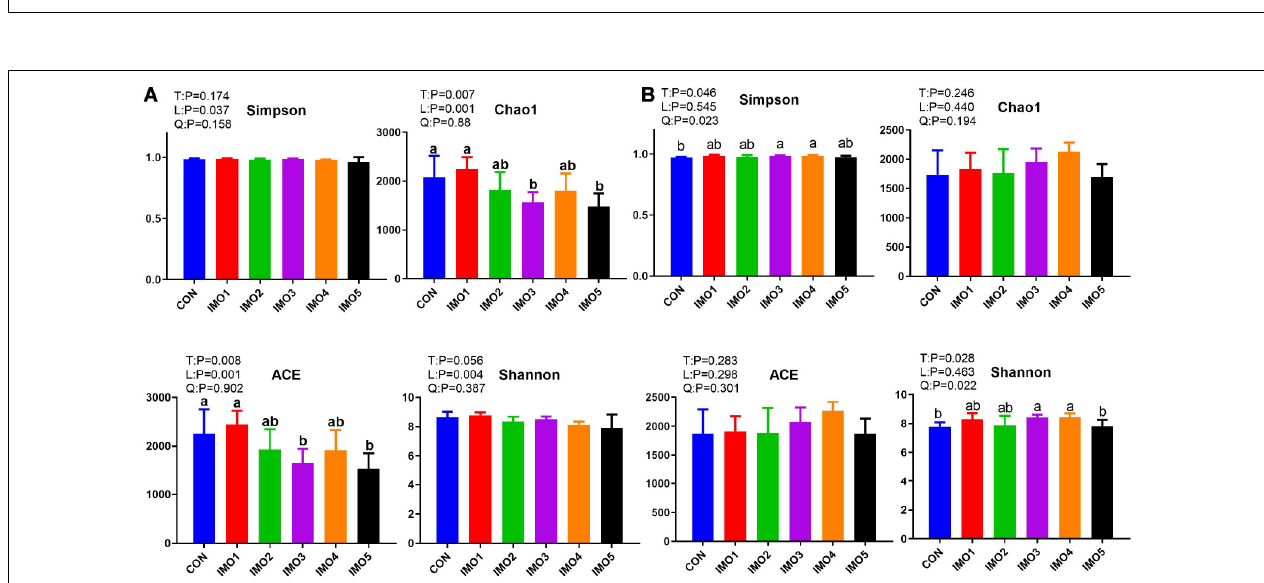
FIGURE 5 | Effects of dietary isomaltooligosaccharide (IMO) levels on the α -diversity of gut microbiota at day 107 of gestation (A) and at day 10 of lactation (B) of sows. Simpson index, Chao1 index, ACE index, and Shannon index. Data are presented as means ± SD ( n = 5). (a–c) Significant effect of treatment ( P < 0.05; values with different lowercase letters are significantly different; T, total; L, linear; Q, quadratic).